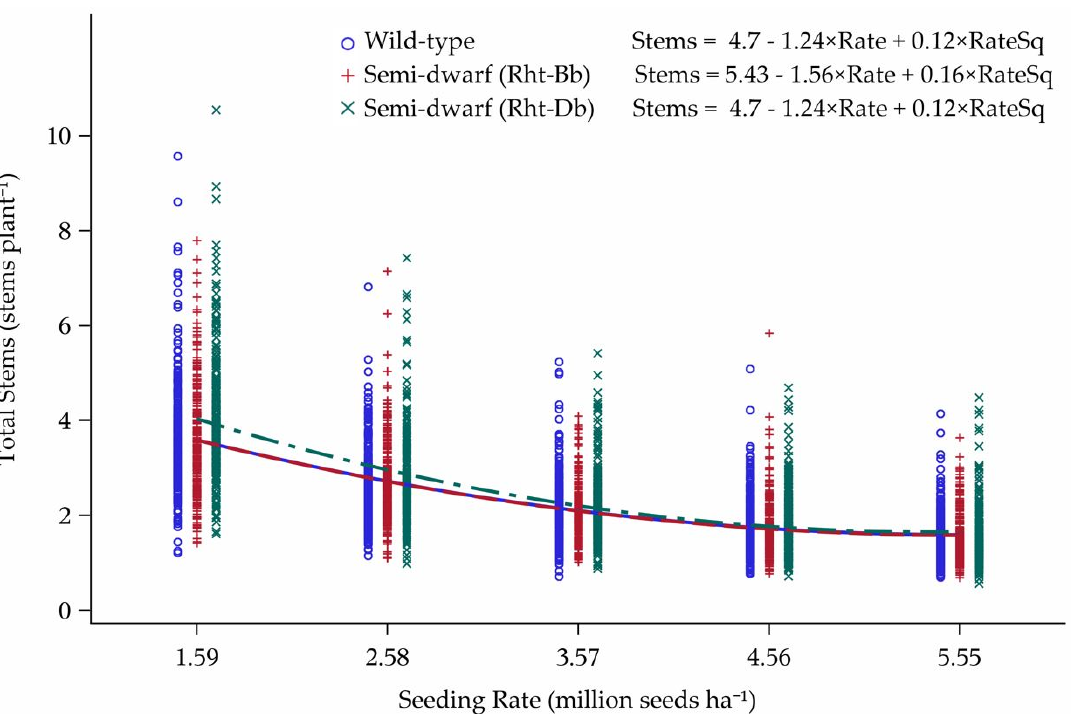
Figure 6. Influence of Rht-Bb , Rht-Db , and Rht-a (wild-type stature) alleles on tillering response to seeding rate over 21 environments in Minnesota and North Dakota, 2013–2015.